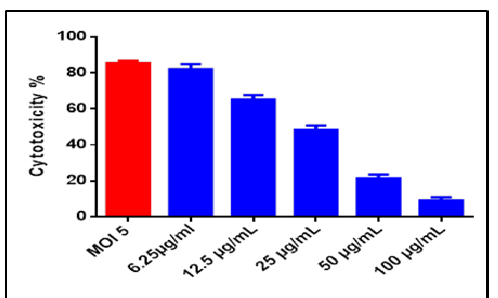
Figure2. Cytoprotecting chart; increasing the concentration of the tested sample (aqueous layer) reduce the cytotoxicity of measles virus on Vero cells using MOI of 5.